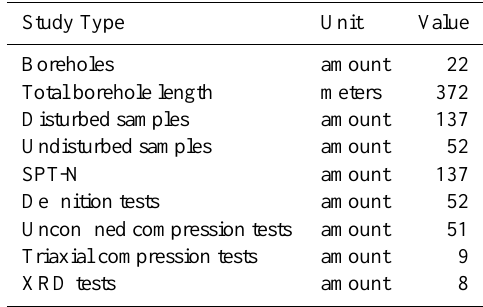
Table 1. Summary of laboratory and field